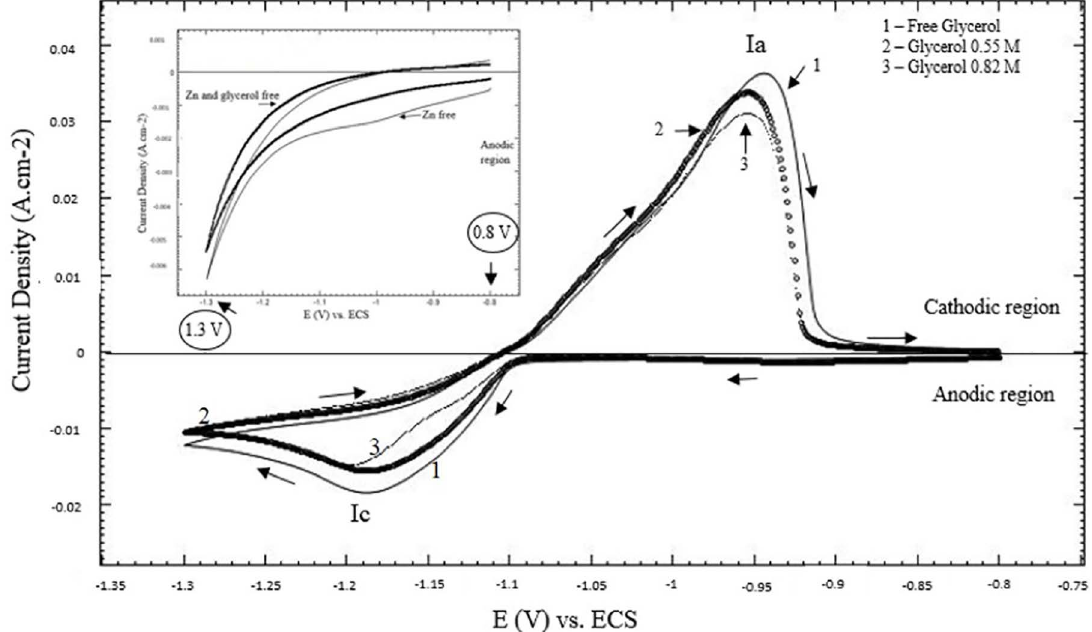
Figure 3. The potentiodynamic polarization curves of 1020 steel substrate immersed in solutions containing different compositions: free, 0.55 M and 0.82 M glycerol